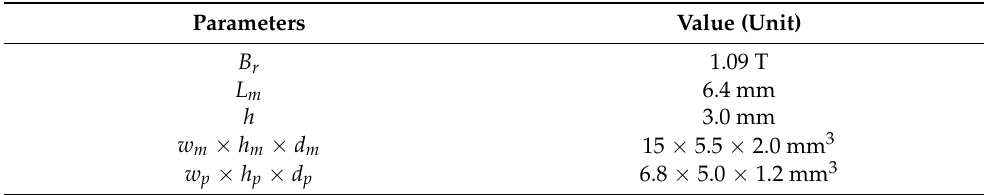
Figure 5. Schematic diagram of the PCM focusing system. Table 2. Parameters of the magnet